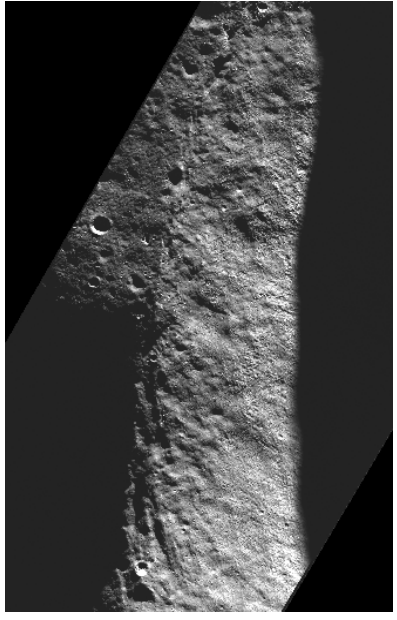
Figure 3. Section of the left pre-rectified input image (M139716114RE) at SR1 site